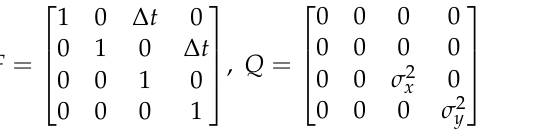
x , y are the horizontal and vertical coordinates R R l are the dis- l , r f